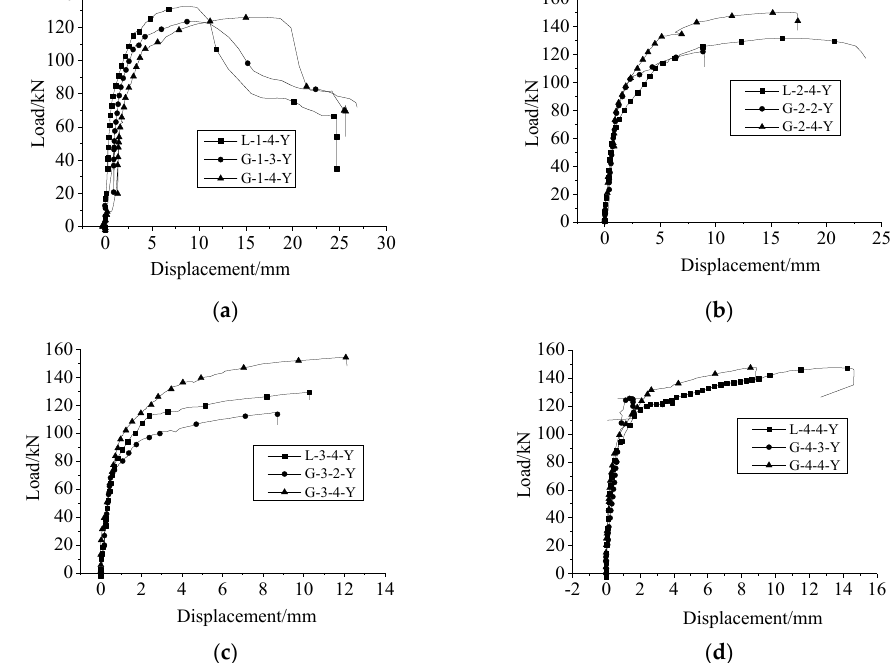
Figure 16. Load–displacement curves of specimens with anti-deflection measures under uniaxial tension and high-stress repeated tension and compression (only the last tensile part) loading (with standard distance ( L + 4 d )). ( a ) L = 6 d, ( b ) L = 8 d, ( c ) L = 10 d, ( d ) L = 12.5 d.